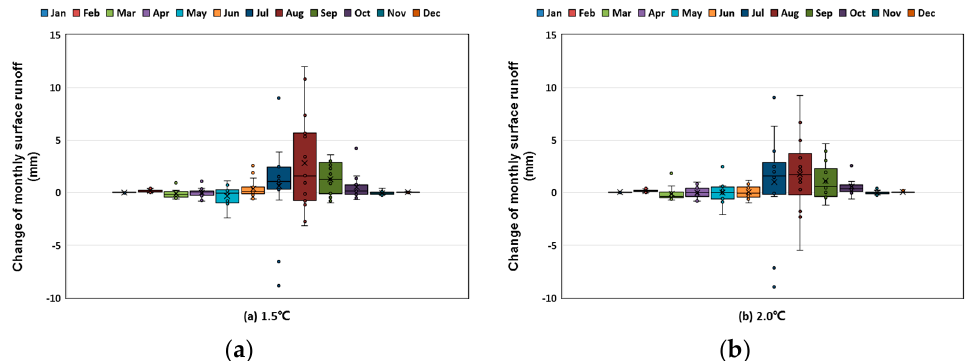
Figure 9. Change of monthly surface runoff refer to baseline period ( a ) 1.5 °C; ( b ) 2.0 °C.